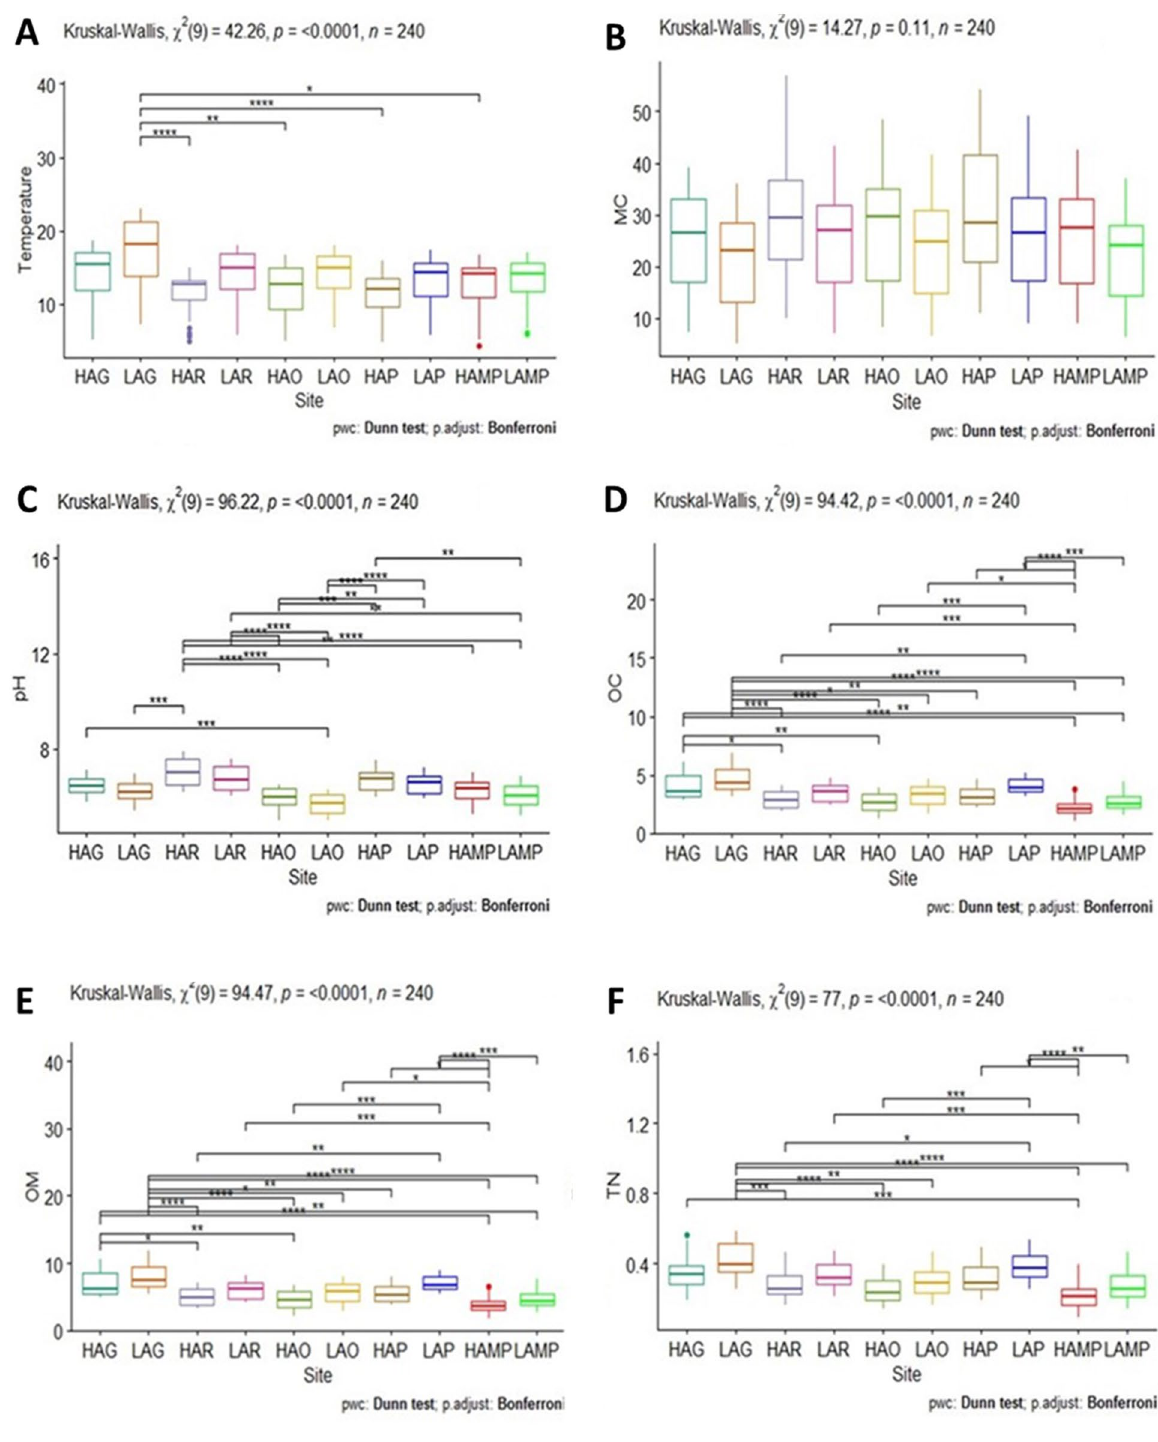
Figure 2. Mean site-wise variations in soil ( A ) temperature (°C), ( B ) moisture content (%), ( C ) pH, ( D ) organic carbon (%), ( E ) organic matter (%), and ( F ) total nitrogen (%) of lower